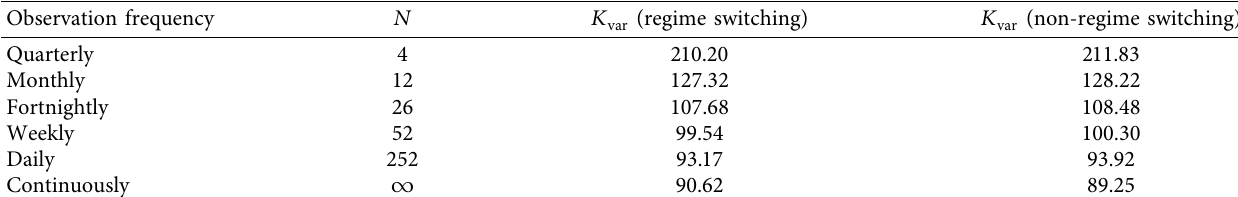
Figure 2: Calculated K from the discrete model, the continuous model, and the semi-Monte-Carlo simulation. var Table 3: Prices of variance swap with regime switching and without regime switching.